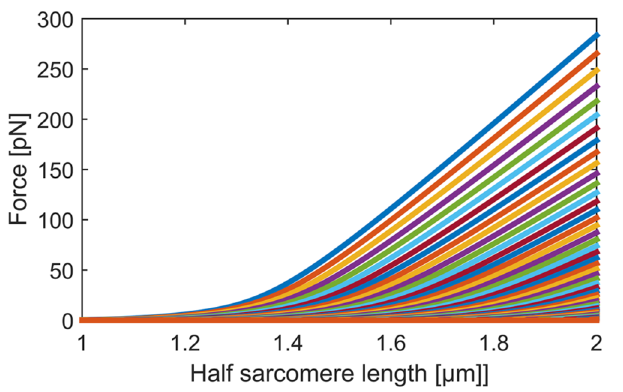
Fig 2. Solution of Eq (3) for stretches from 1 μ m to 2 μ m half sarcomere lengths. Force [pN] of single titin strands at a given half sarcomere length is a discrete random variable with 51 states. The top curve represents the state in which all Ig domains are folded, the next curve the state in which exactly one Ig domain is unfolded, etc.